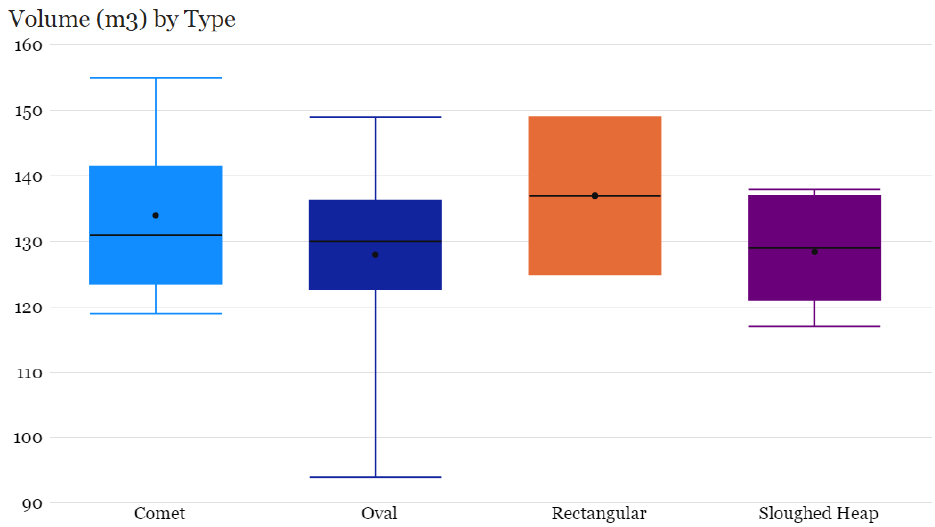
Figure 2. Box Charts of Volume (m 3 ) by Dump Profile Shape.